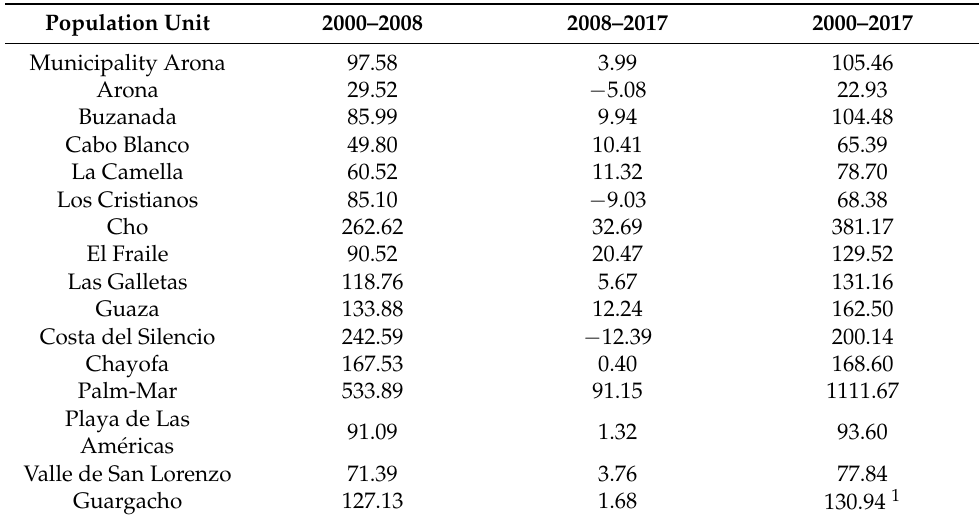
Table 1. Population growth in % in the municipality Arona